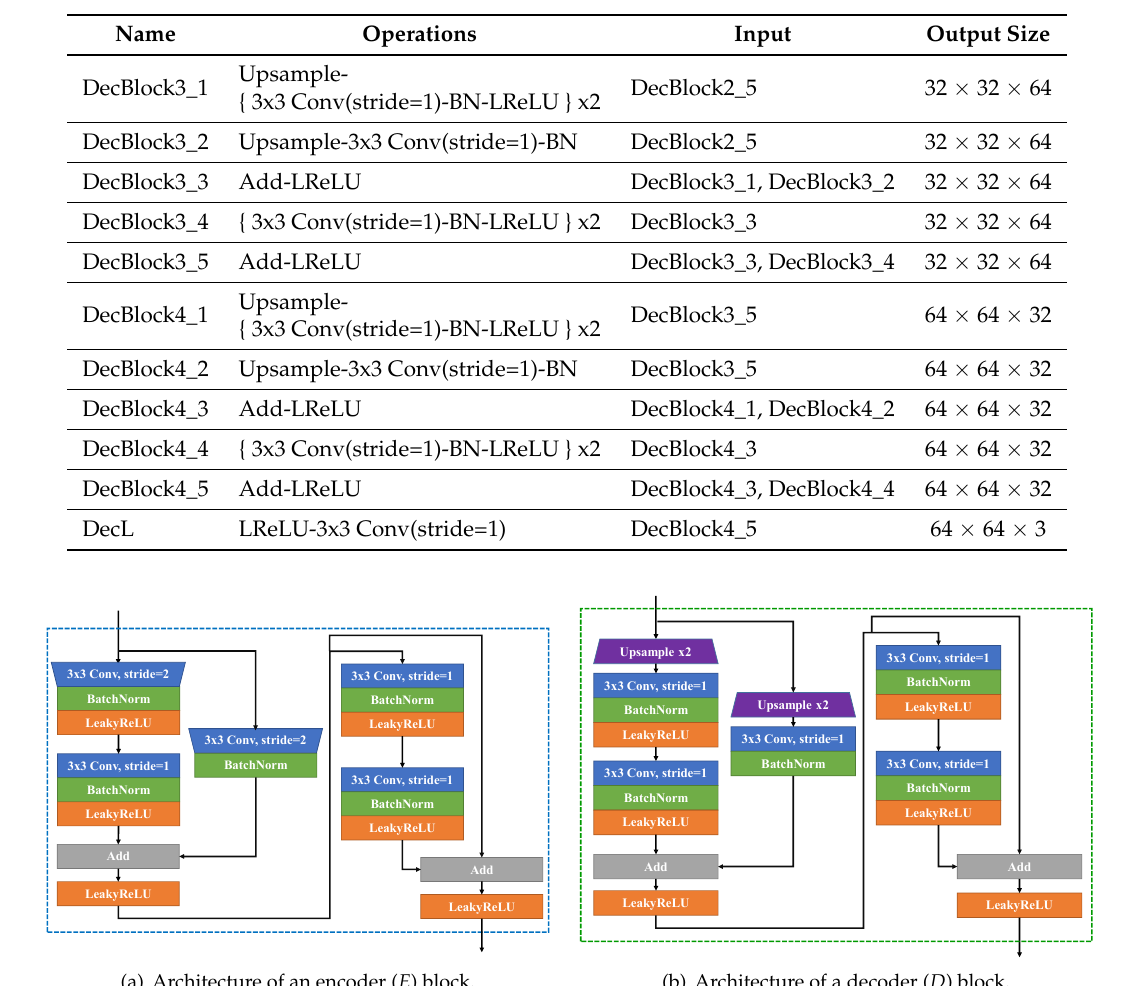
Figure 3. Architectures of blocks of the encoder and the